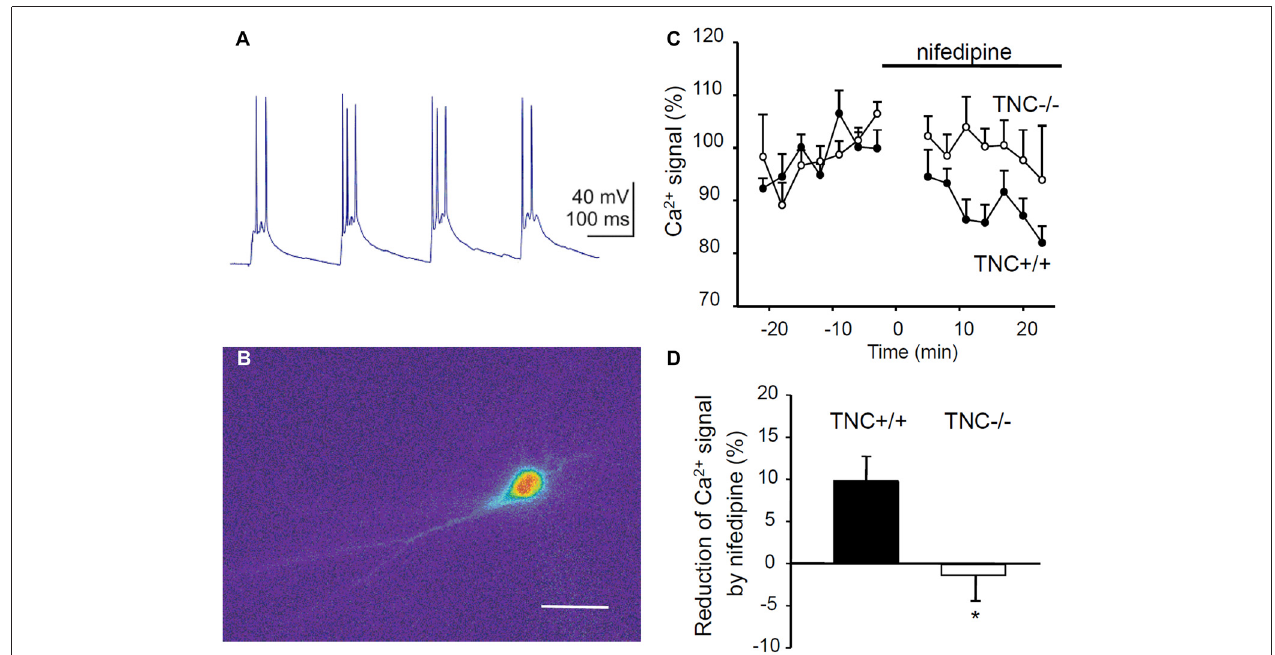
FIGURE 4 | Reduction of Ca 2 + entry via L-VGCCs in TNC deficient mice. (A) Intracellular recording of the CA1 pyramidal cell response to theta-burst synaptic stimulation. In each burst, 2–3 action potentials were generated on depolarization peaks. (B) Changes of the fluorescence of the calcium indicator Oregon Green 488 BAPTA-1 during the response of CA1 pyramidal cell to TBS. The panel shows the difference in the fluorescence between two frames acquired with 400 ms exposure before and during the TBS. Scale bar: 40 µ m. (C) The time-course of Ca 2 + signal changes induced by application of the L-VGCC blocker nifedipine (horizontal bar). Mean values of Ca 2 + signals 0–25 min before nifedipine application were set to 100%. (D) Summary of the reduction of theta-burst-induced Ca 2 + signals by nifedipine. Means and SEM of signals measured repeatedly 5–25 min after nifedipine application in 12 TNC + / + and 10 TNC − / − mice are presented, ∗ p < 0.05, t